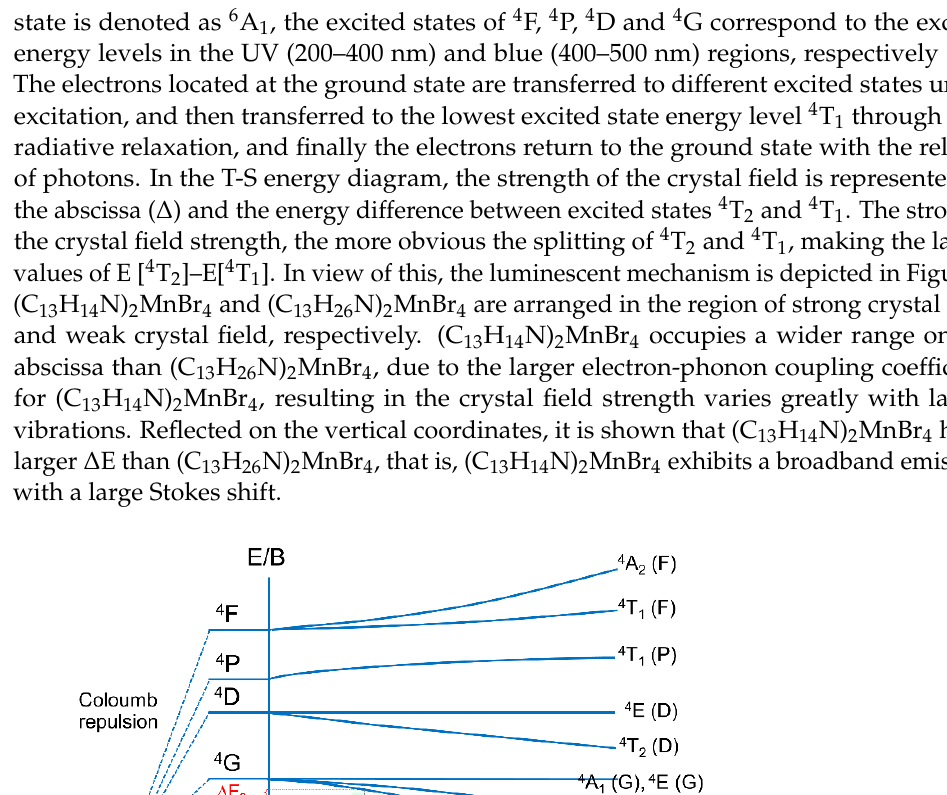
Figure 6. Emission spectrum of w -LEDs based on ( a ) (C 13 H 14 N) 2 MnBr 4 and ( b ) (C 13 H 26 N) 2 MnBr 4 . The insets show the photographs of w -LEDs in the daylight (top) and working at 20 mA (bottom). ( c ) CIE 1931 colour coordinates of fabricated LED-1 (orange dotted line), LED-2 (red dotted line) and the NTSC standard (black dotted line). 4. Conclusions In summary, the two new 0D manganese bromides were developed by using organic cations with different spatial configuration. (C 13 H 14 N) 2 MnBr 4 exhibits a broadband emis- sion peaked at 539 nm with a FWHM of 63 nm and a Stokes shift of 70 nm, while